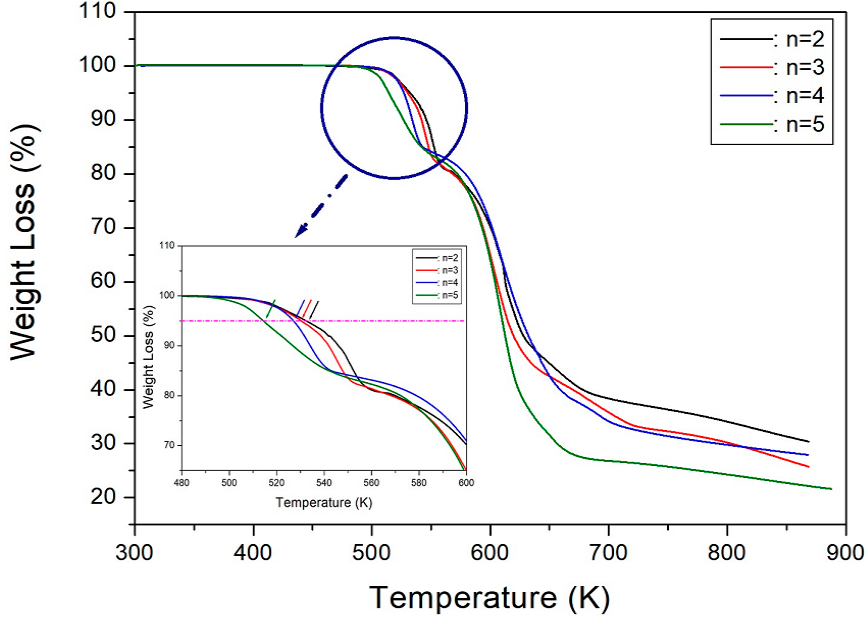
Figure 9. TGA curves of [NH 3 (CH 2 ) n NH 3 ]CuCl 4 ( n = 2, 3, 4, and 5) (inset: expansion of TGA curves near T d ).